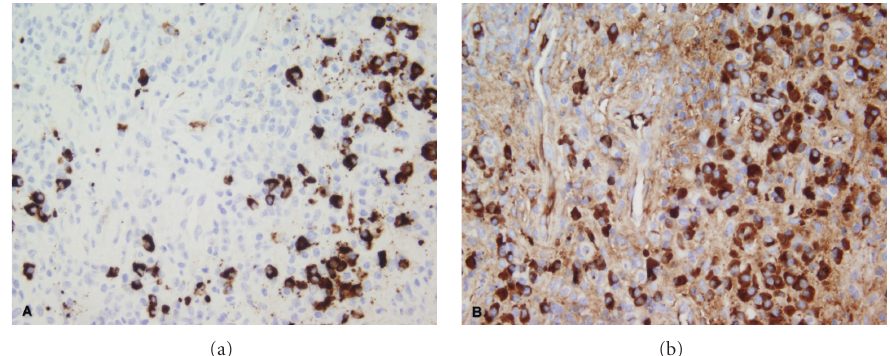
Figure 1: (a) Increased IgG4-positive cells with a high IgG4+/IgG+ ratio. (b) IgG+ cells from corresponding hotspot (immunohistochem- istry, 400x original